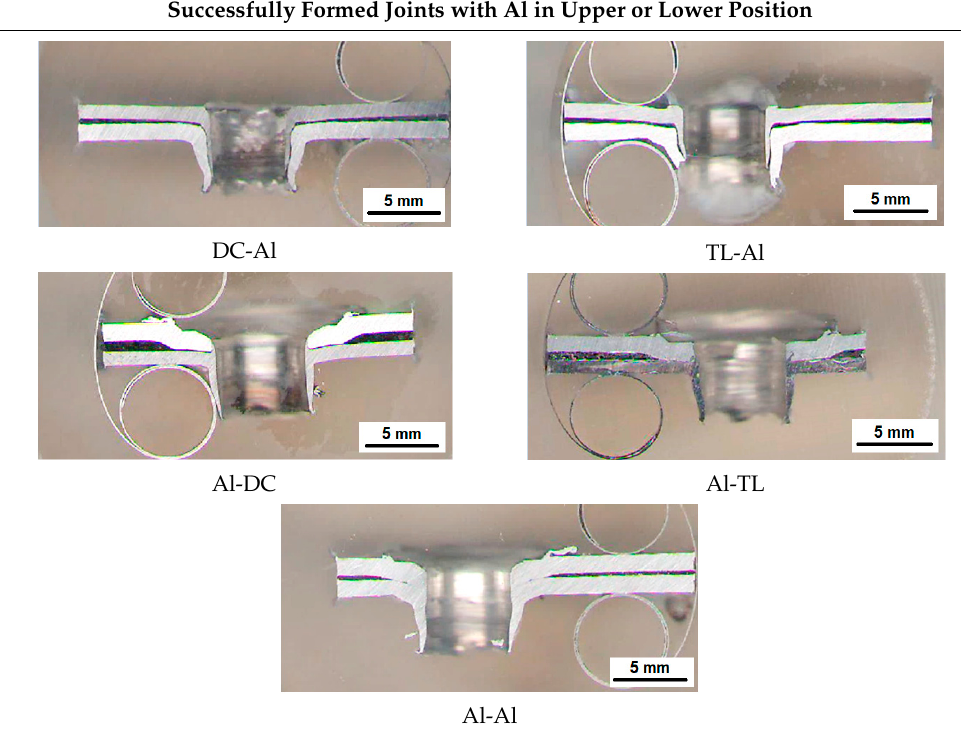
Table 8. Macroscopic sections of individual combined joints.